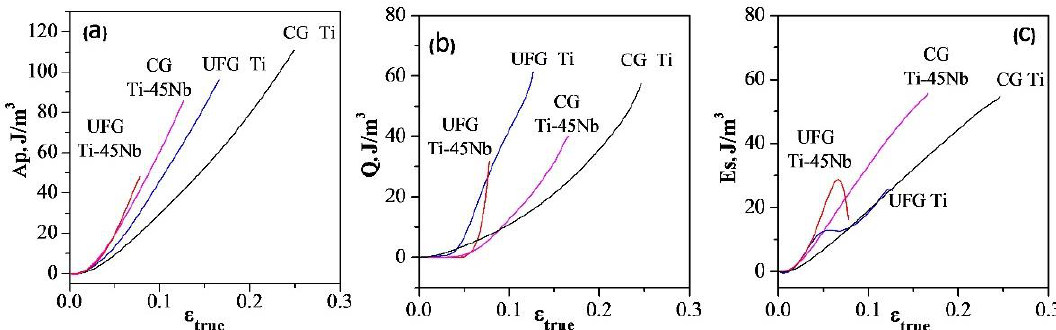
Figure 7. Energy released during deformation as a function of the true strain. Ap — plastic deformation energy ( a ), Q — heat energy released during deformation ( b ), Es — energy stored in the process of deformation ( c ). Table 2. Amount of specific energy released during uniaxial tension in the pure titanium and Ti-45Nb alloy in the CG and UFG